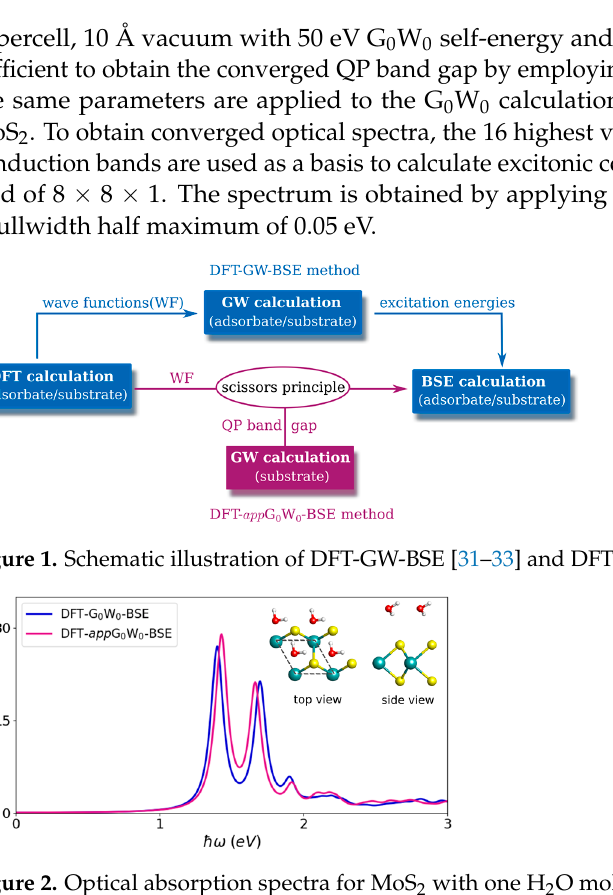
Figure 2. Optical absorption spectra for MoS 2 with one H 2 O molecule in a unit cell by DFT-G 0 W 0 - BSE and DFT- app G 0 W 0 -BSE methods with PBE functional. The spectra are obtained by applying a Lorentzian broadening of 0.05 eV. For both cases, the electronic band gap is 2.48 eV. The correspond- ing structure is also shown.